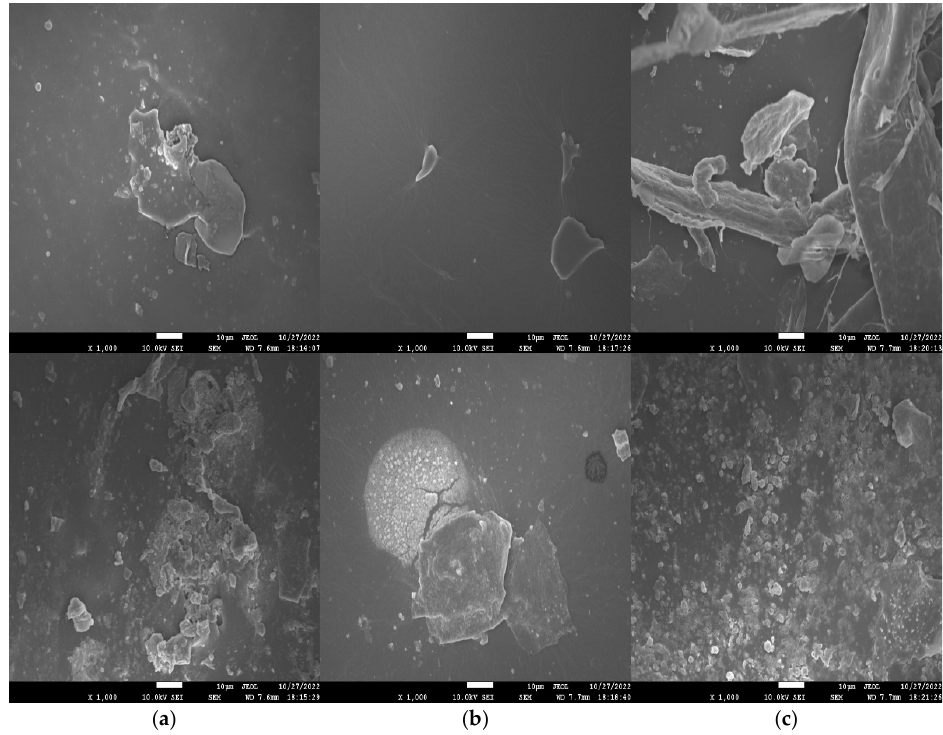
Figure 6. SEM images (top view) of ( a ) WPU − g − BTA − A, ( b ) WPU − g − BTA − B and ( c ) WPU − g − BTA − C before corrosion (top) and after corrosion (bottom) in 3.5 wt% s after 3 days of immersion.